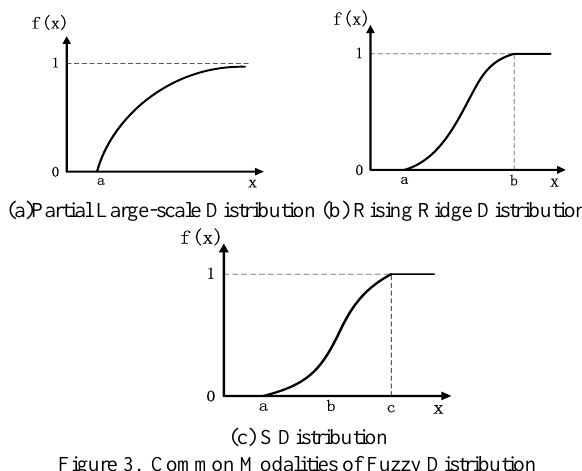
Figure 3. Common Modalities of Fuzzy